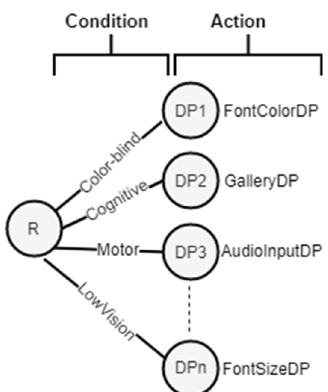
Figure 4. Partial list of rules for selecting UI design patterns.